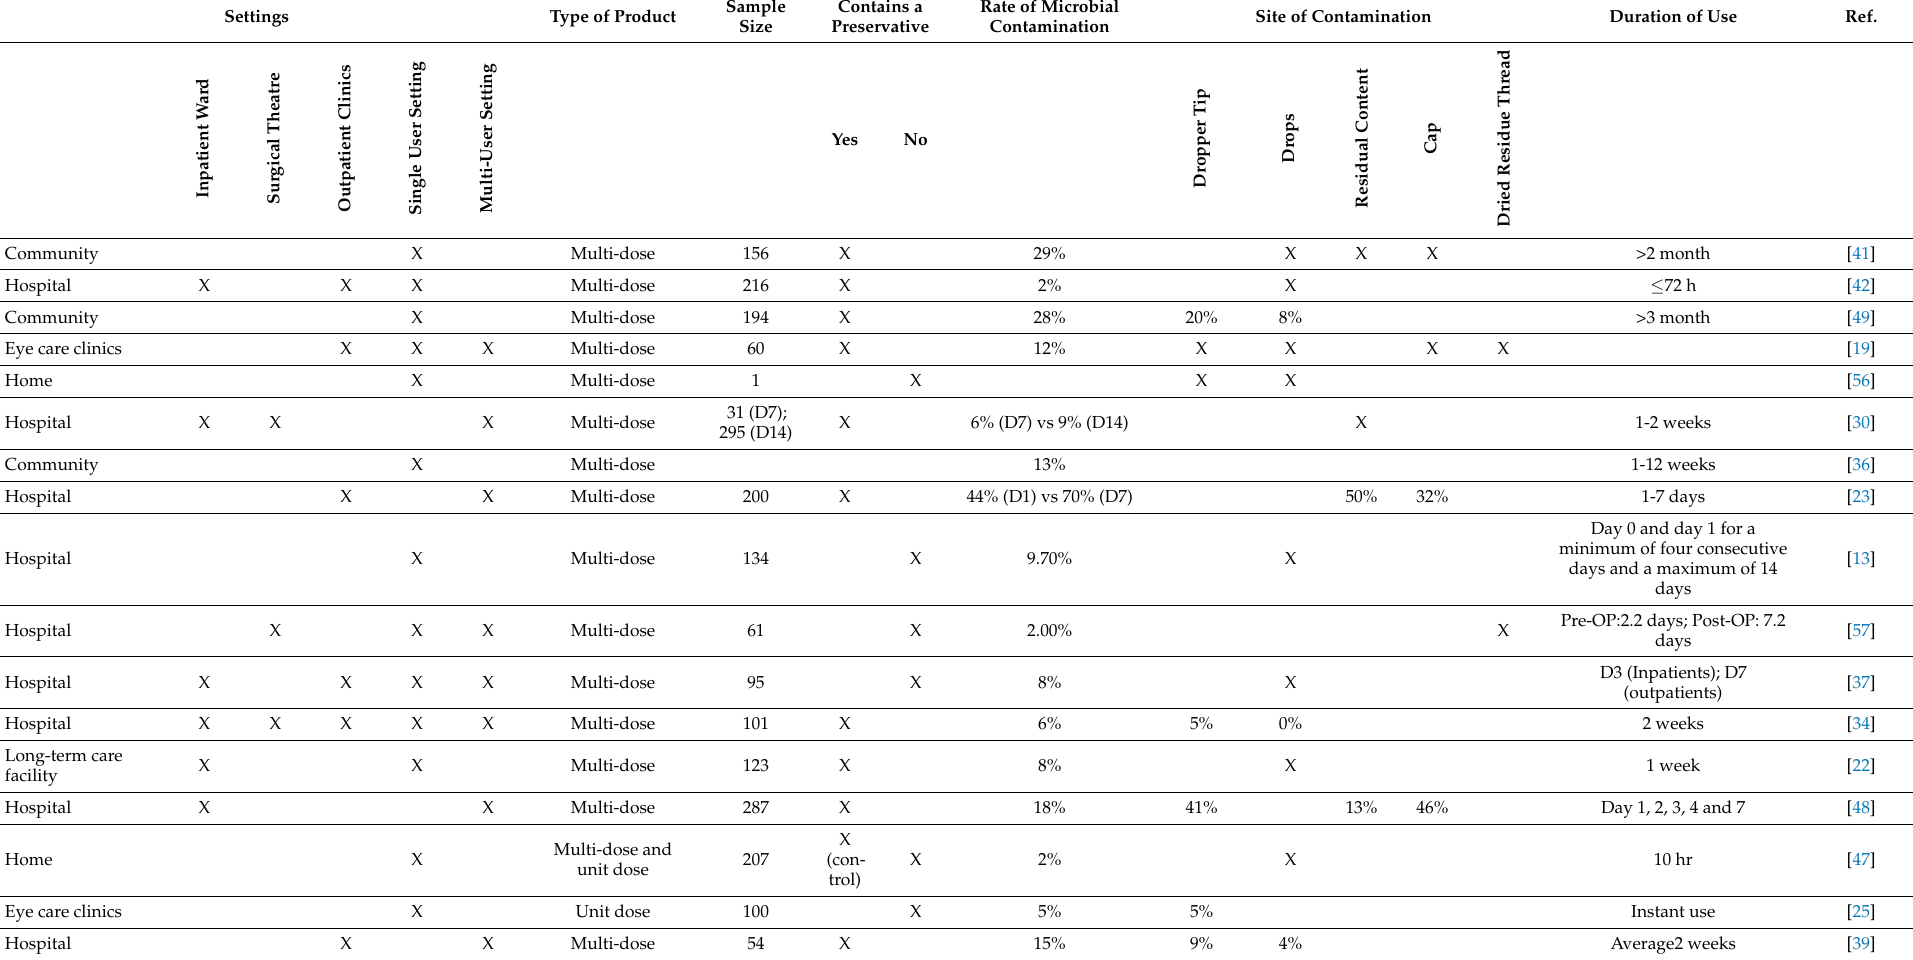
Table 2. Microbial contamination of in-use eye